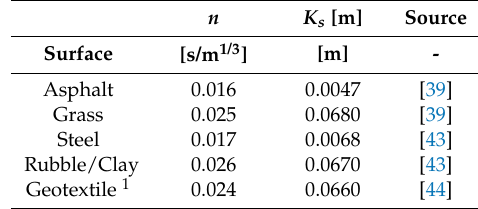
Table 2. Roughness coefficients used for both road and crest models from [39].